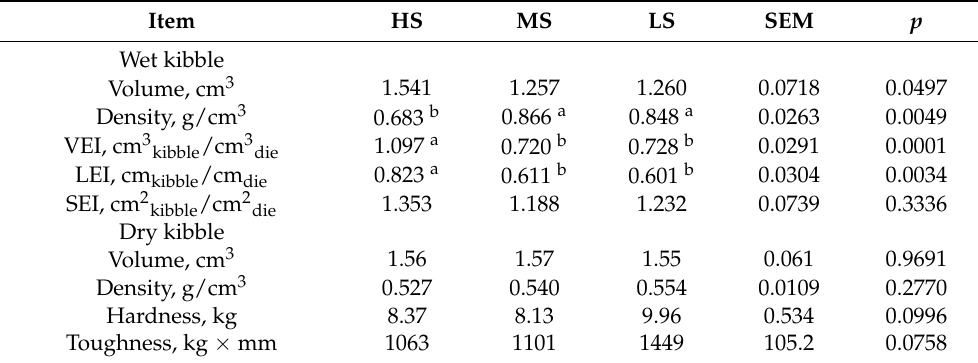
Table 4. Kibble parameters and texture analysis of X115 low, medium, and high RS diets (HS, MS, and LS,